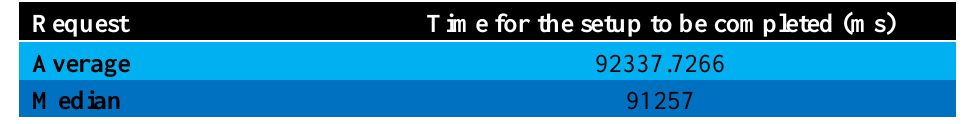
Table 3. Most Significant Measures Obtained for WSN